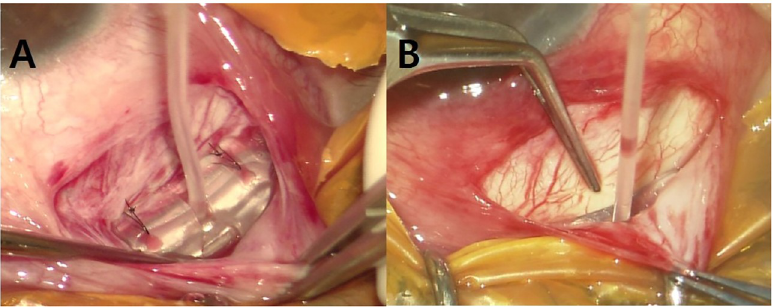
Fig 1. Comparison of conventional Ahmed glaucoma valve (AGV) implantation featuring scleral plate fixation, and free-plate AGV implantation. In conventional AGV implantation, the body of the AGV is fixed on both sides to the sclera at the front edge of the plate (A). Free-plate AGV implantation, does not feature scleral fixation (B).